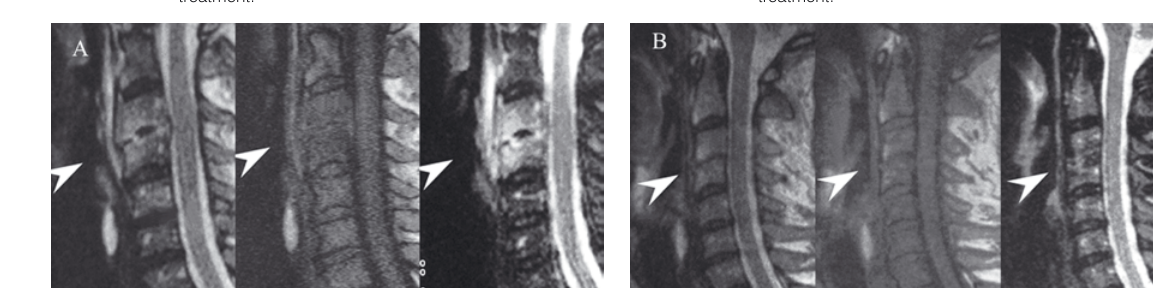
Figure 2. Case 1: A sagittal T1, T2-weighted and TIRM magnetic resonance images in the 9th month of the antituberculous treatment.